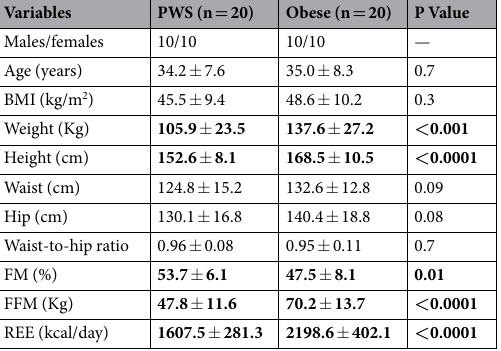
Table 1. Summary of anthropometric data obtained in PWS subjects and obese controls. Data are expressed as mean ± SD. Comparison between populations was performed by ANOVA test. Significant differences are shown in bold characters. BMI, body mass index; FM, fat mass; FFM, fat free mass; REE, resting energy